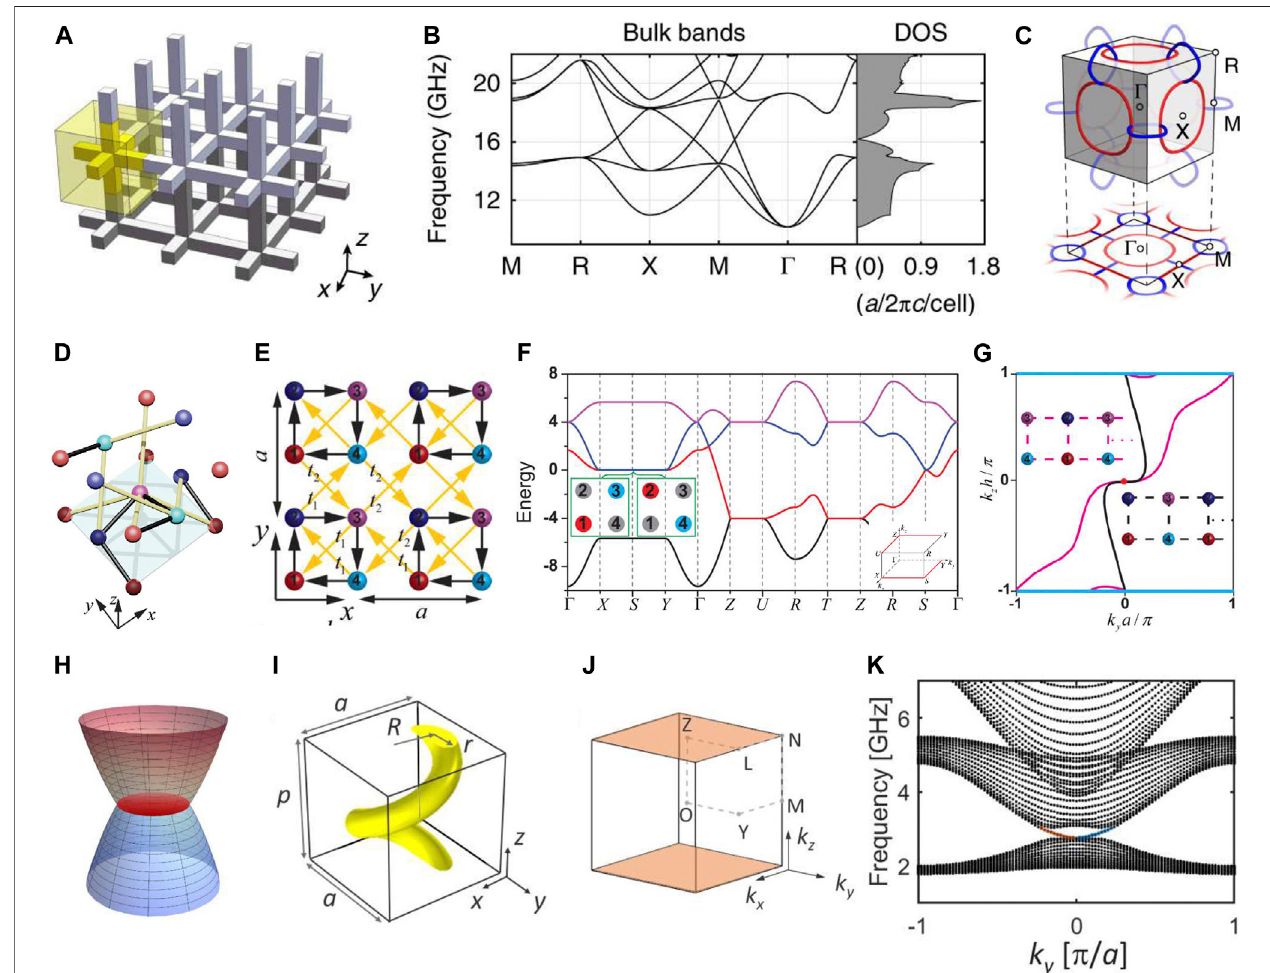
FIGURE5|(A) Schematicillustrationfornodalchainphotoniccrystal[83]. (B) Thebulkbandstructureanddensityofstates. (C) Thestructureofnodalchainsinthe Brillouin zone. (D) Tight binding model for a charged nodal line [37]. (E) The projection of the tight binding model on the x – y plane. (F) The band structures with charged nodal lines are formed by geometric frustration. (G) Equifrequency contour on the k y – k z surface Brillouin zone. The red dot and cyan line represent the projection of the charged +2 Weyl point and the charged -2 nodal chain. (H) Schematics of a nodal surface [38]. (I) Schematic of a unit cell of the nodal surface photonic crystal. (J) Brillouin zone with the high-lighted nodal surface. (K) Surface state dispersion at k x (cid:1) 0 and k z (cid:1) 0 . 5 π / p .